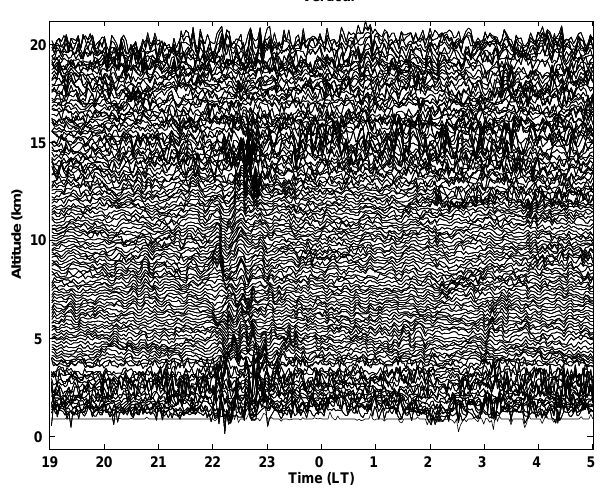
Fig. 4. Frequency spectra of short-period zonal (solid) and merid- ional (dashed) wind fluctuations at a few heights (a, b, c, d) . Height profiles of zonal (solid) and meridional (dashed) amplitudes of < 2h oscillation (e)